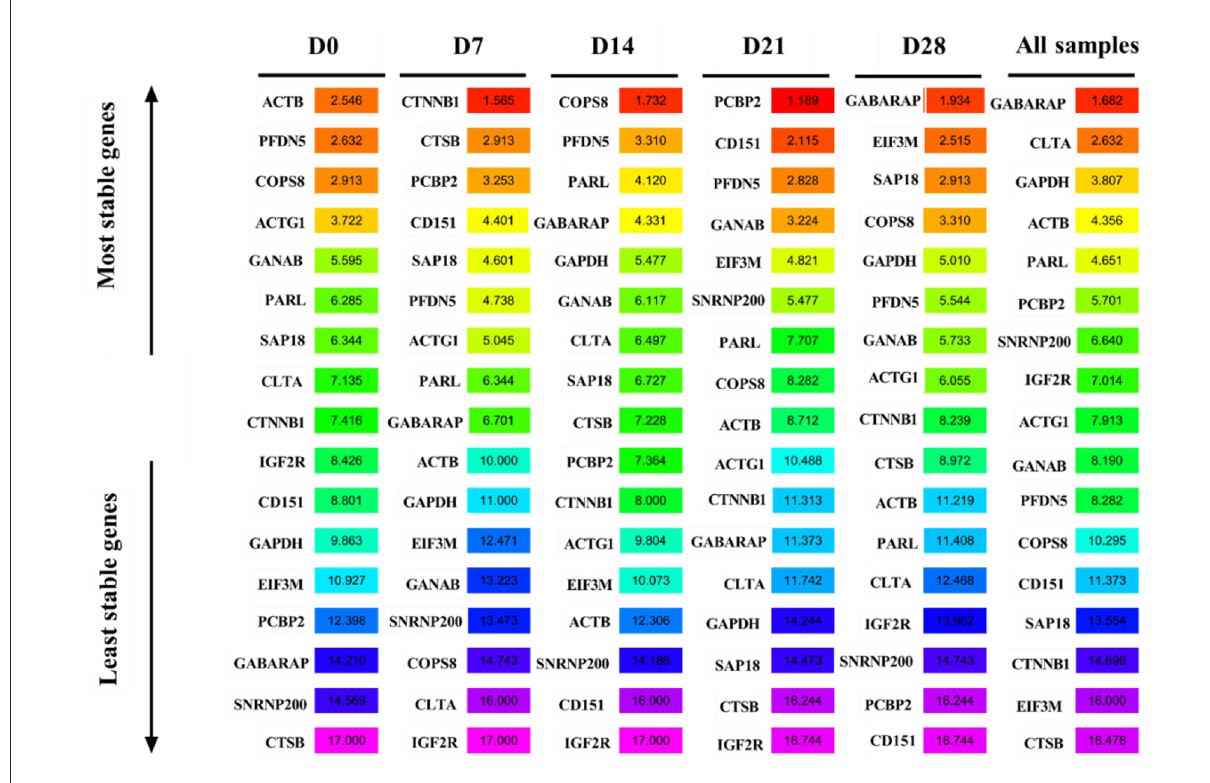
FIGURE8 RefFinder analysis the expression stability of candidate reference